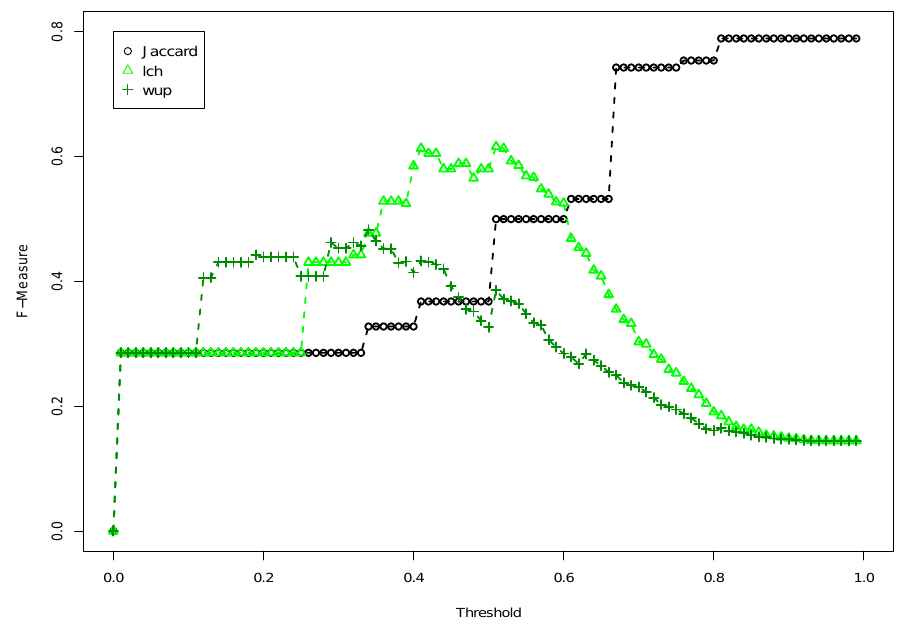
Figure 5. Semantic dissimilarity evaluation using word similarities derived from WordNet, based on a path length